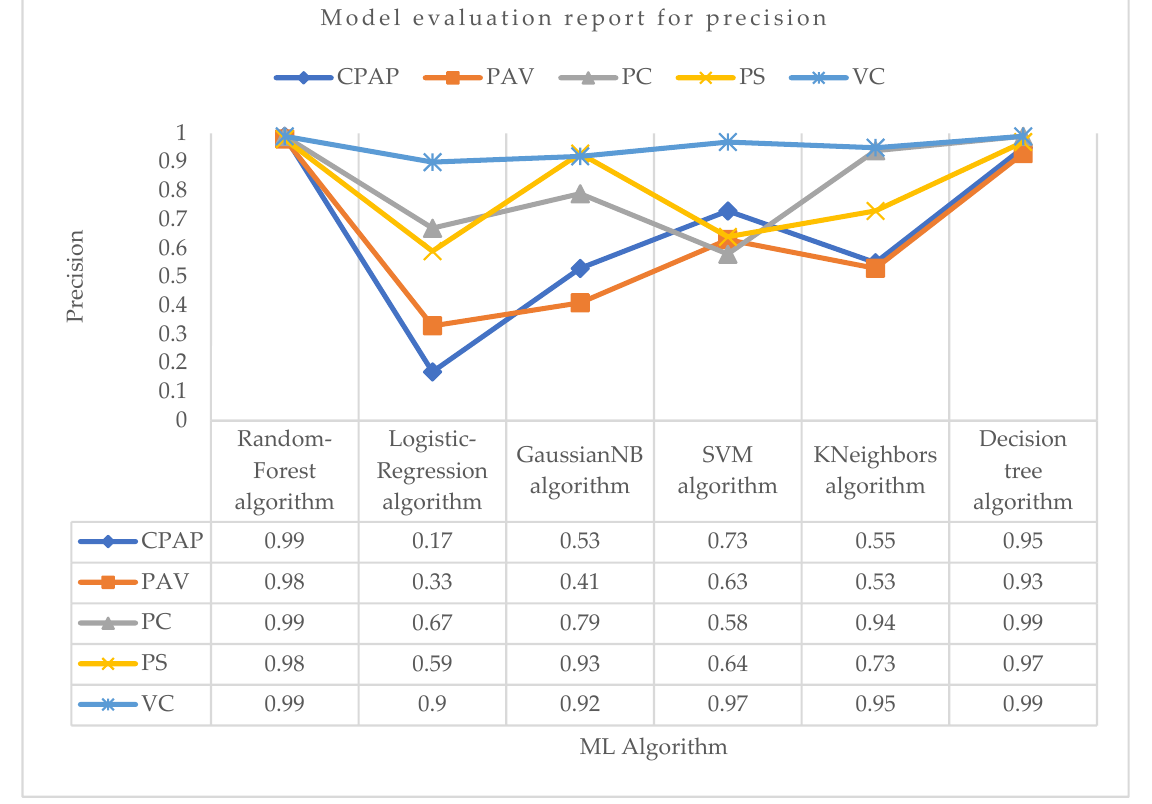
Figure 6. Model evaluation report of precision for different modes and ML algorithms.